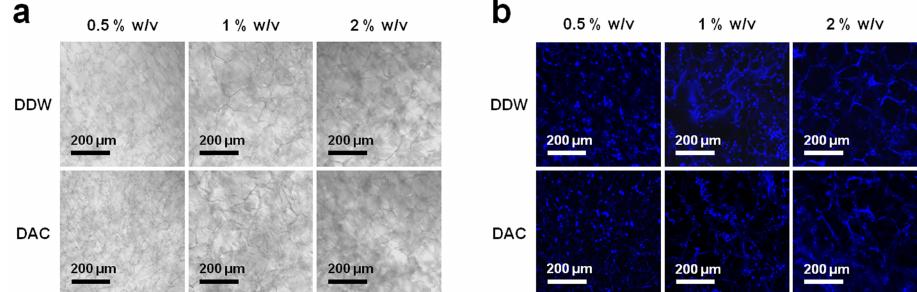
Figure 10. Optical and fluorescence microscope images of adipose-derived stem cells (ADSCs)-seeded porous scaffolds. ( a ) Both DDW- and DAC-collagen scaffolds show a pore structure. ( b ) ADSCs distributed along the pore wall can be observed via DAPI staining (at day 1 after cell